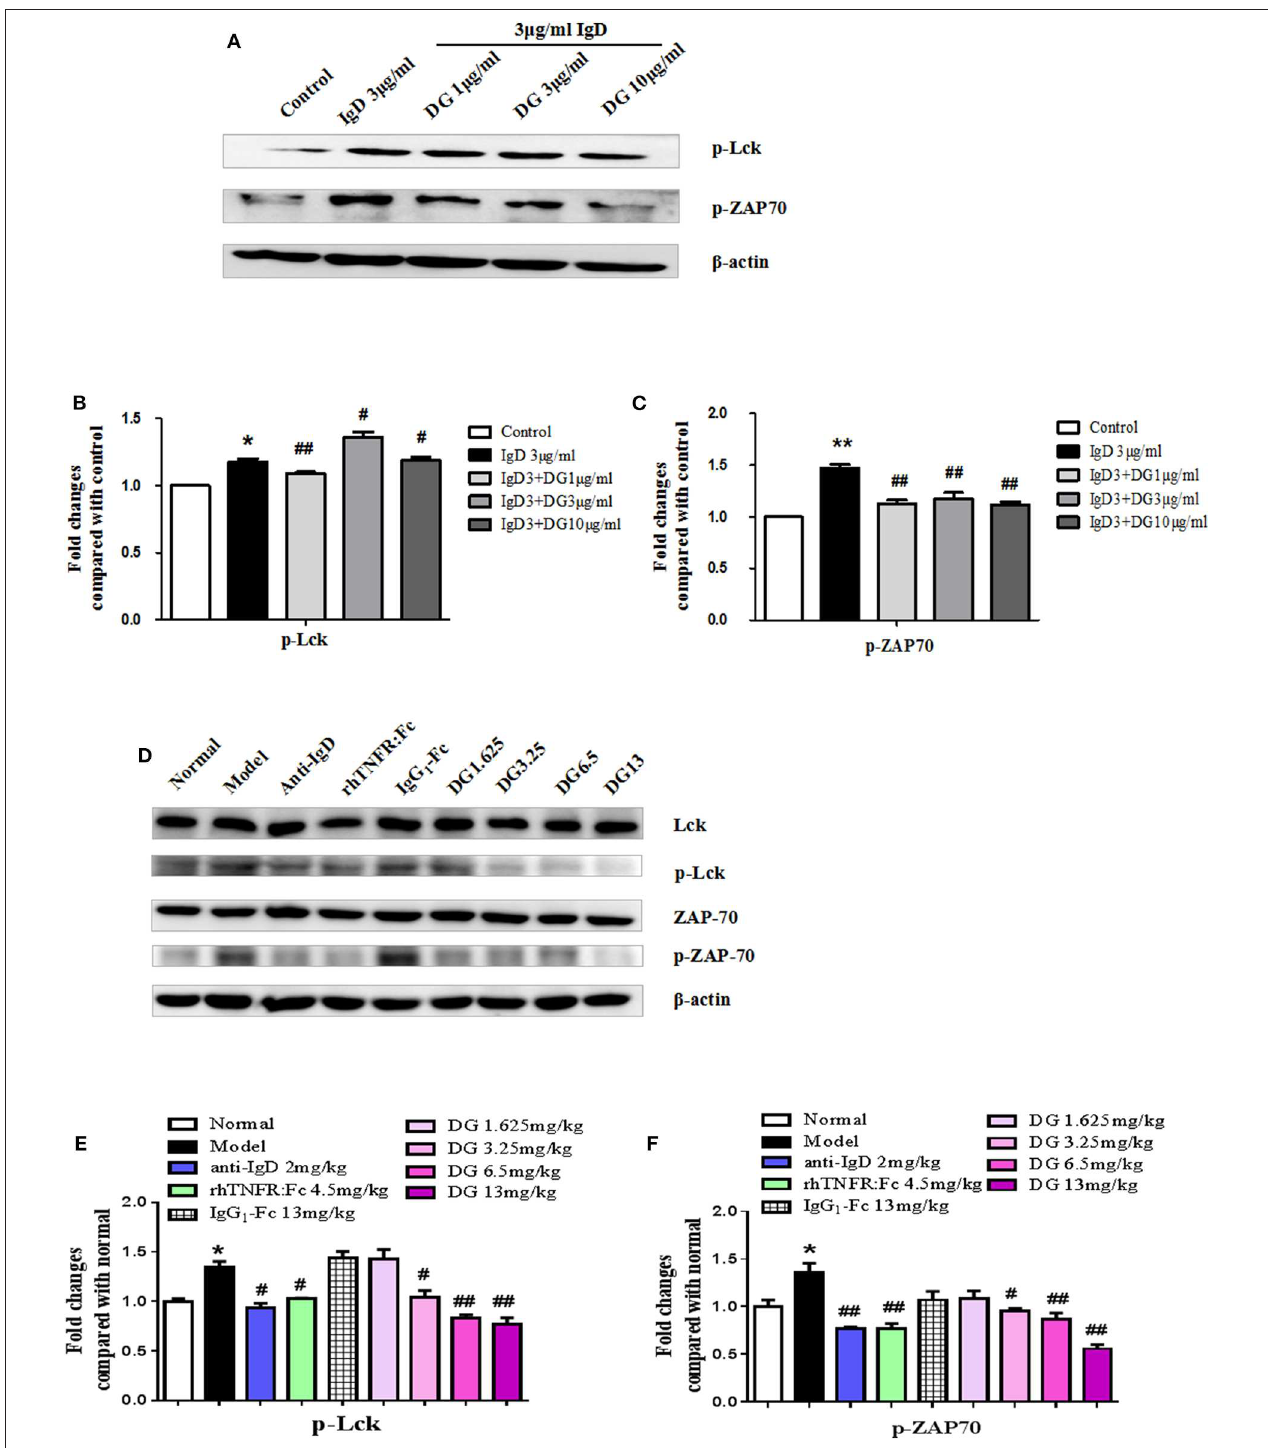
FIGURE 9 | Effects of IgD-Fc-Ig (DG) on the protein expression of Lck, p-Lck, ZAP70 and p-ZAP70. (A–C) Western blot analysis of p-Lck and p-ZAP70 expression in PBMCs of RA patients, PBMCs were treated with IgD (3 µ g/mL) and IgD-Fc-Ig (1, 3, 10 µ g/mL) for 48h and lysed. (D–F) Western blot analysis of Lck, p-Lck, ZAP70 and p-ZAP70 expression in CIA mice. Mice spleens from each group were isolated and homogenized in lysis buffer. Data were expressed as mean ± SEM ( n = 3). * P < 0.05 and ** P < 0.01 vs. Control and Normal, # P < 0.05 and ## P < 0.01 vs. IgD (3 µ g/mL) group and Model.